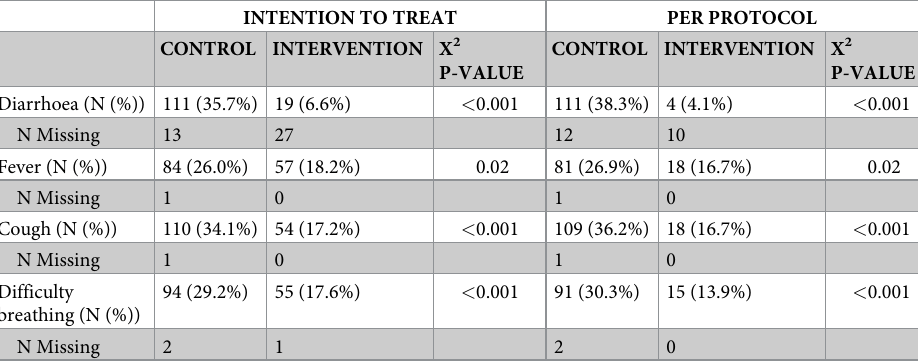
Table 5. Childhood illness outcomes in the control and intervention